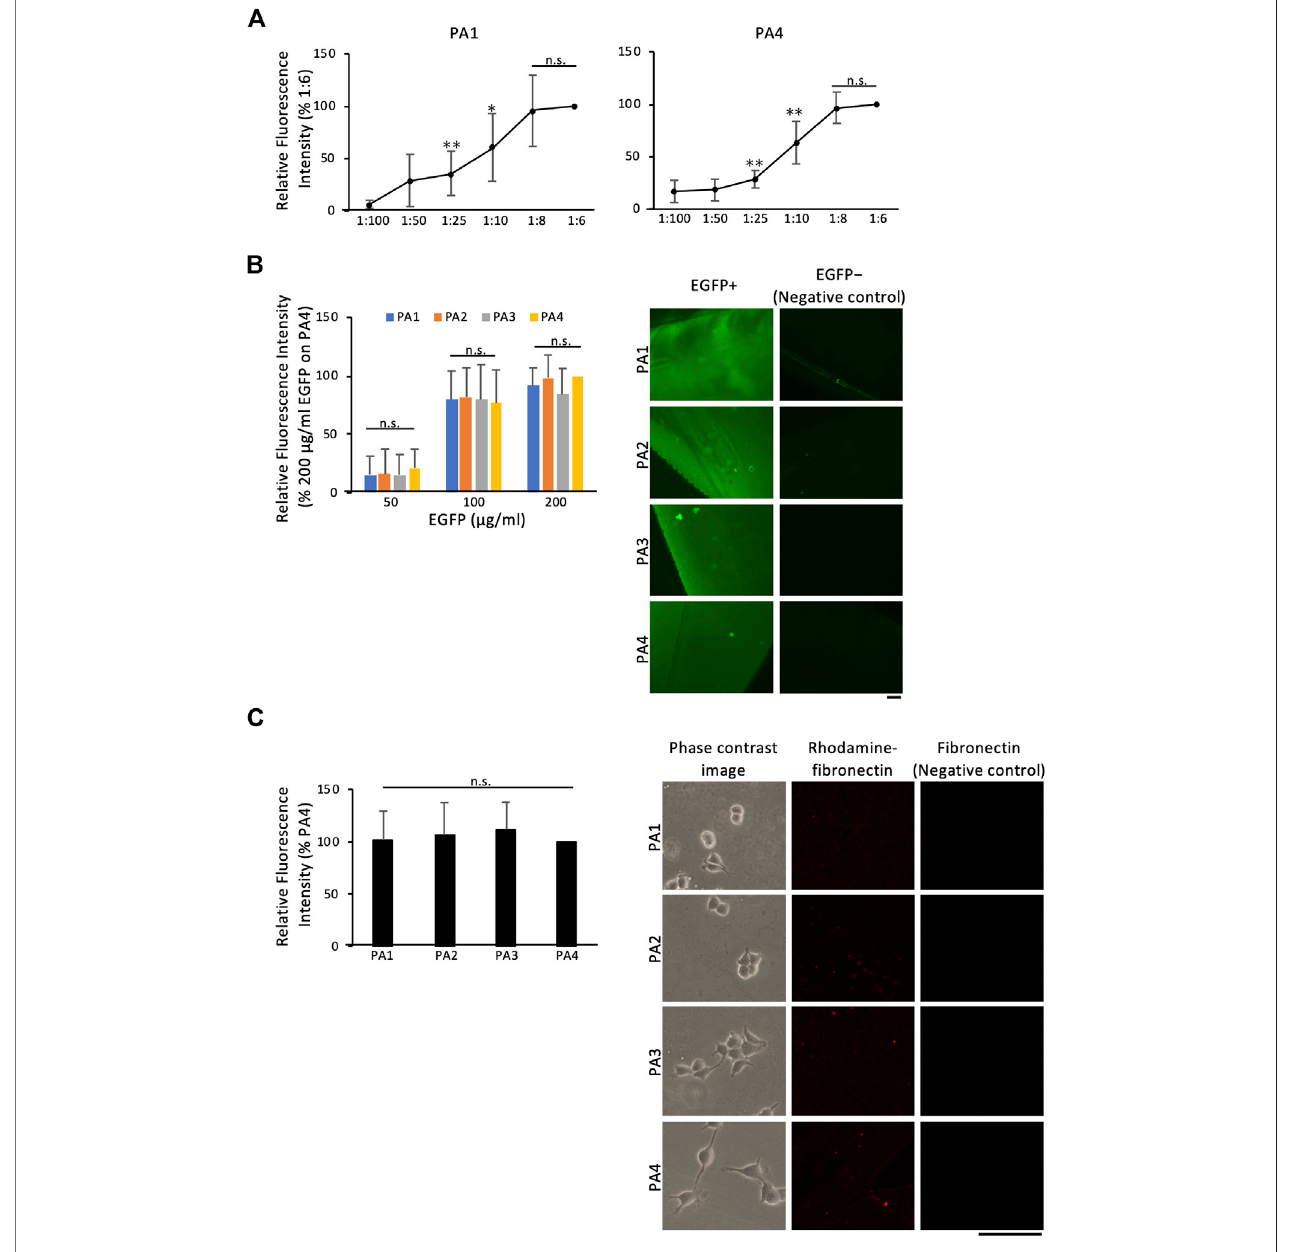
FIGURE 4 | Protein coating ef fi cacy of PA gels containing NHS-AA ester. Protein coating ef fi cacy was determined using EGFP and rhodamine- fi bronectin (A) The fl uorescent intensity of EGFP (200 µg/mL) reached saturation on both soft and stiff gels (PA1 and PA4, respectively) at mixing ratios above 1:8 (B) The amount of EGFP coating thegels wasproportional to theamount applied (left) , and EGFP coating ef fi cacywas similar among gels of different stiffness (right) (C) Rhodamine- fi bronectin coating wassimilaramong gels of different stiffness. The mean ofthree independent replicates ± the SD (left) are shown.Scale bar: 100 µm.** p < 0.01, * p < 0.05, n.s., not signi fi